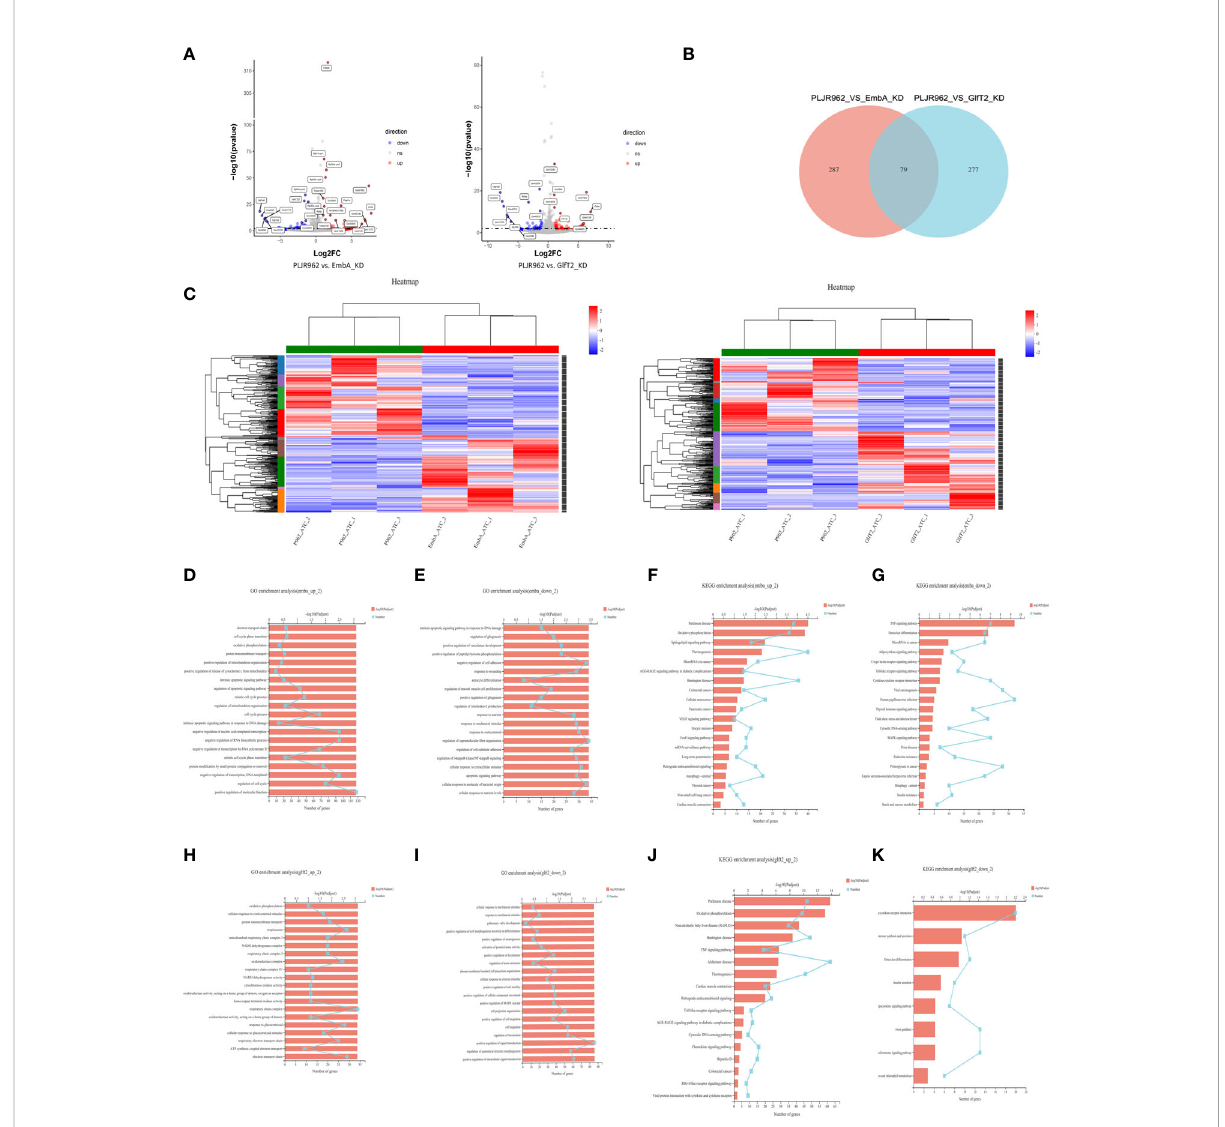
FIGURE 6 Transcriptome analysis of EmbA/GlfT2_KD strain-infected murine macrophage line J774A.1 (MOI = 5, 12 h). (A) Volcanic map of the differential quality of differentially expressed genes (DEGs). The abscissa is the multiple of the gene/transcript expression difference between the two samples, and the ordinate is the statistical test value of gene expression difference. A larger -log10 ( p -value) indicates a more signi fi cant difference in expression. The values of horizontal and vertical coordinates were logarithmically processed. Each dot represents a speci fi c gene. The software edgeR was used for DEG analysis, and the screening threshold was |log2FC| ≥ 1 and the p -value was <0.05. (B, C) Venn diagram and clustering heat map of DEGs in the two groups of knock-down strains compared with the control group, and there are 10 subclusters in both groups. Each column represents a sample, and each row represents a gene. The color in the fi gure denotes the expression level of the gene after a standardized treatment in each sample; red indicates a high expression level, while blue means a low expression level. On the left side of the heat map is the tree diagram of gene sub-clustering, and on the right side is the name of the genes. The upper part represents the tree of sample clustering. The closer the branches of the two samples are, the closer the variation trends of the gene expression levels are. (D, E) Gene ontology (GO) enrichment analysis of genes up/downregulated in macrophages infected with the EmbA_KD strain. The ordinate represents the GO term, and the lower abscissa represents the number of genes/transcripts compared to the GO term, corresponding to different points on the broken line. The upper horizontal coordinate represents the signi fi cance level of enrichment, corresponding to the height of the column. A smaller p -value (adjusted) indicates a larger value of − log10 ( p -adjusted); thus, the more signi fi cant it is means that the GO term is enriched. (F, G) Kyoto Encyclopedia of Genes and Genomes (KEGG) pathway enrichment analysis of genes up/downregulated in macrophages infected with EmbA_KD strain. The vertical axis represents the KEGG pathway, and the horizontal axis represents the number of genes/transcripts compared to this pathway, corresponding to the different points on the broken line. The upper horizontal coordinate represents the signi fi cance level of enrichment, which corresponds to the height of the column. A smaller false discovery rate means a larger − log10 ( p -adjusted) value and a more signi fi cantly enriched KEGG pathway. (H, I) GO enrichment analysis of genes up/downregulated in macrophages infected with the GlfT2_KD strain. (J, K) KEGG pathway enrichment analysis of genes up/downregulated in macrophages infected with the GlfT2_KD